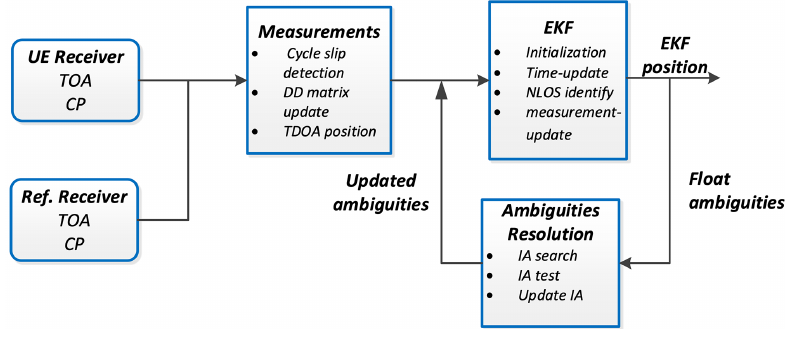
Figure 2. Flowchart of TOA/Carrier Phase combined Real-Time